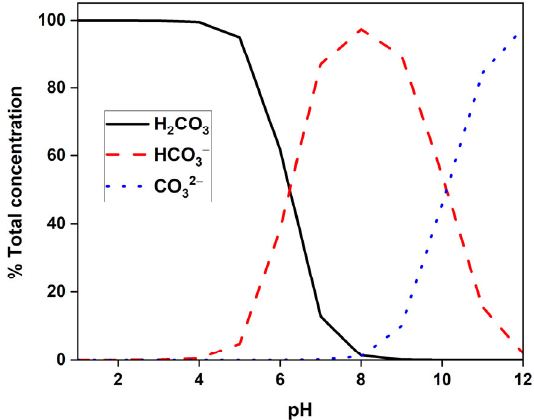
Figure 1. pH-dependent speciation of CO 32 − species obtained from visual MINTEQ version 3.1, KTH, Sweden.